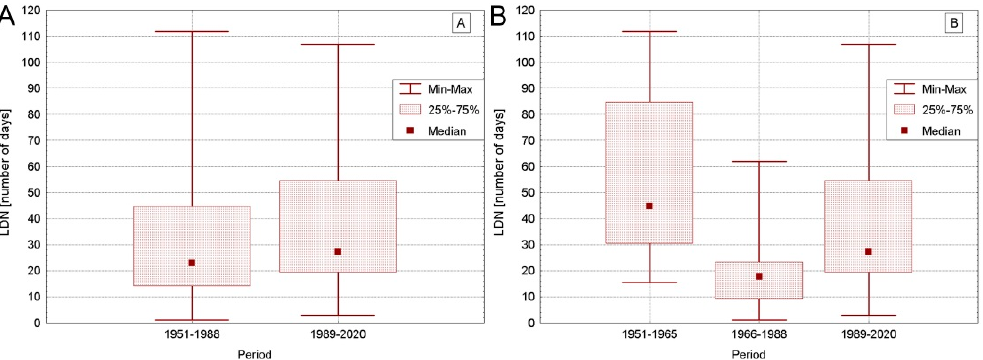
Figure 9. Ranges of variability of the average number of days with low flows (ND LF ) in sub-periods before (1951–1988) and after climate change (1989–2020) ( A ) and in three sub-periods corresponding to different macro-circulation epochs ( B ).